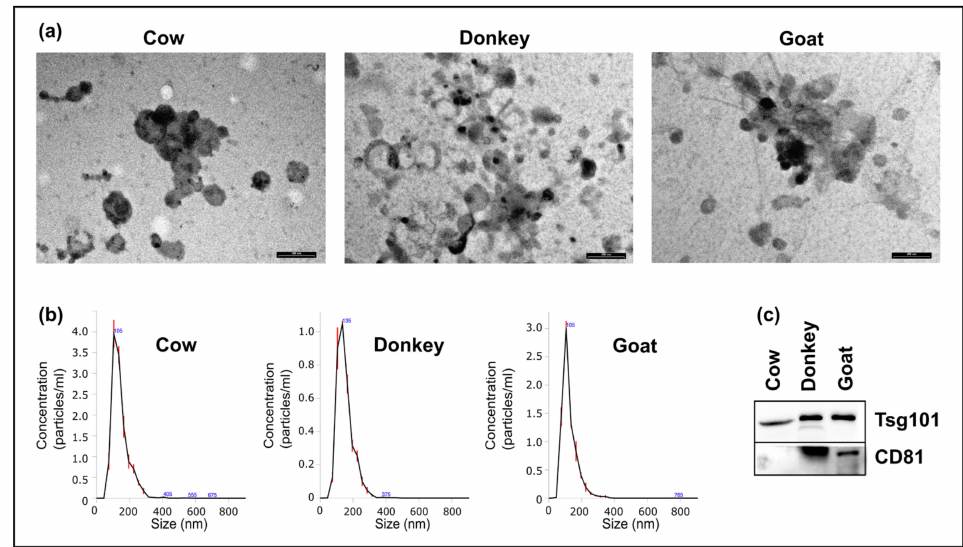
Figure 2. Morphological characterization of mEVs: ( a ) Transmission electron microscopy (TEM) revealed the presence of single and aggregated vesicles mainly in the range of 30–150 nm. Scale bar: 200 nm; ( b ) Size distribution of vesicles measured using the Nanosight NS300 nanoparticle tracking analysis system. The peak of the mEV size distribution was 105 nm for cow and goat and 135 for donkey; ( c ) Western blot results of Tsg101 (Tumor Susceptibility gene 101 protein) and CD81 (Cluster of Differentiation 81) tested mEV